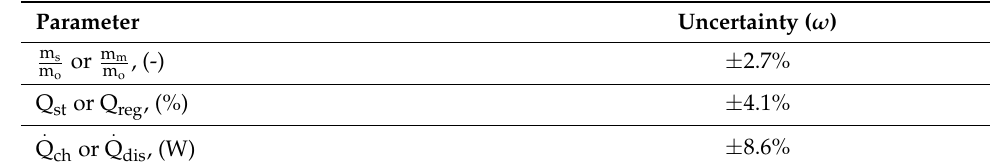
Table 5. The main parameters’ average